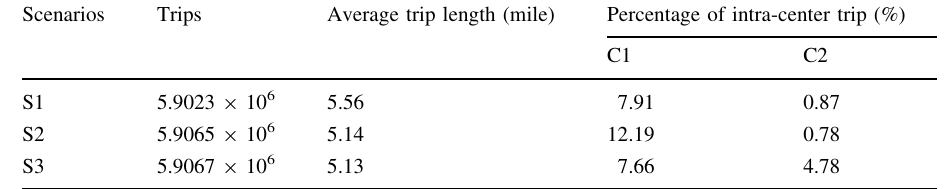
Table 3 Number of trips, average trip length, and percentage of intra-center trips